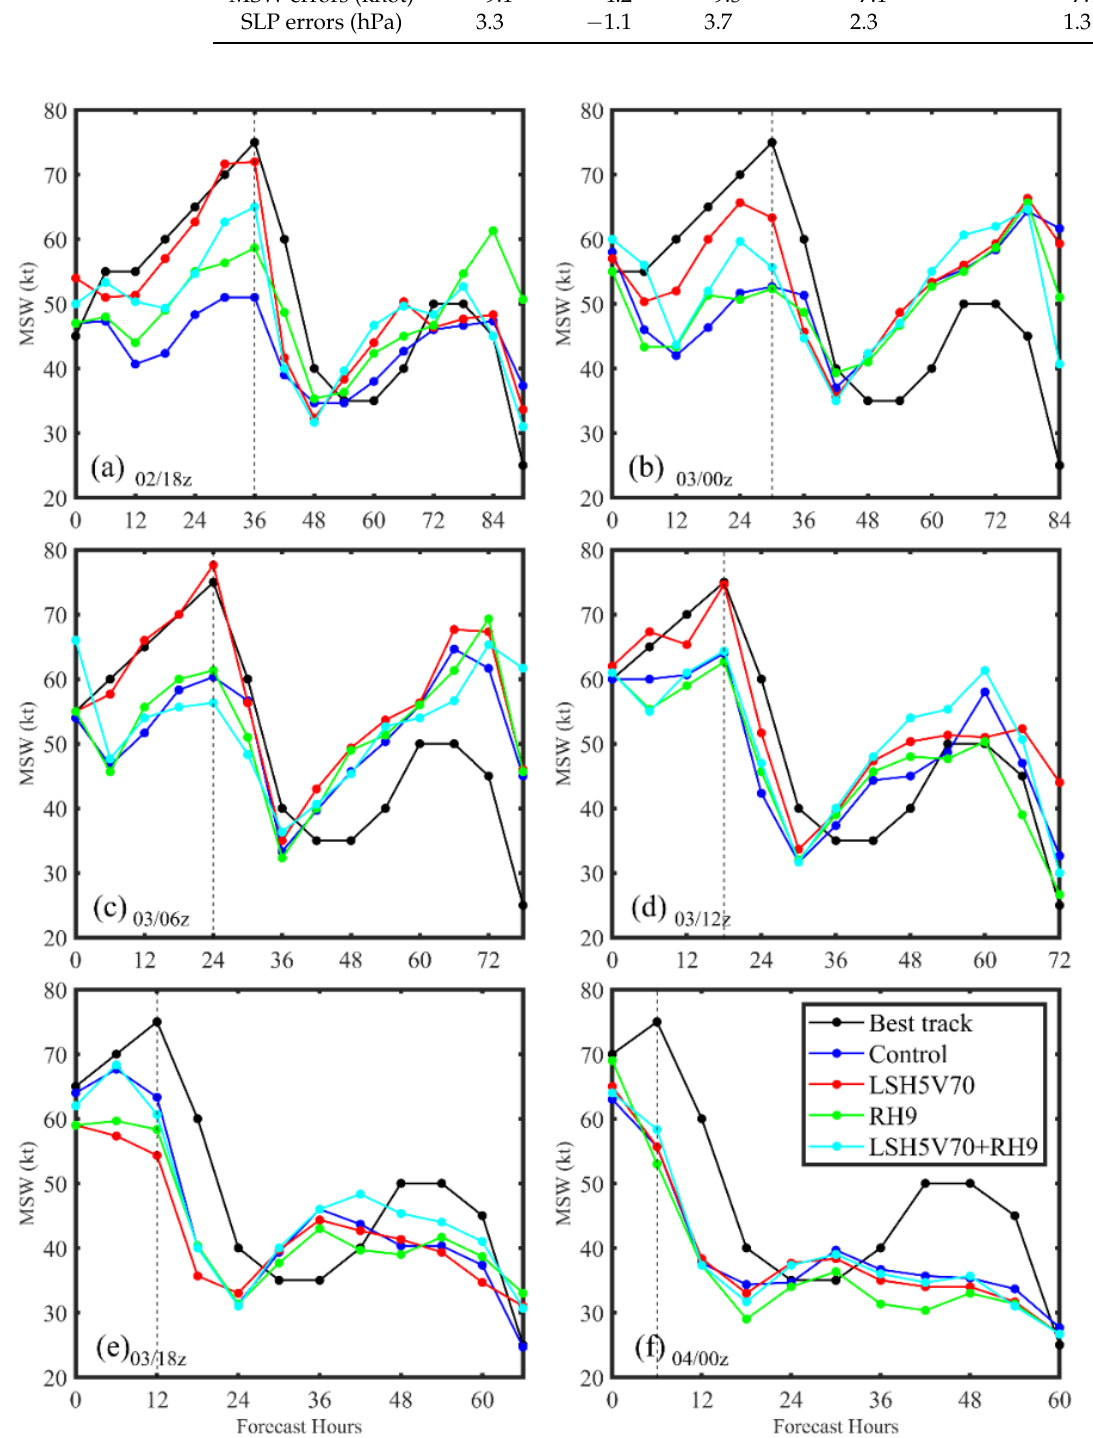
Figure 10. Comparison of the forecast MSW for Hurricane Earl from Control, LSH5V70, RH9, and LSH5V70 + RH9 at ( a ) 18 UTC 2, ( b ) 00 UTC 3, ( c ) 06 UTC 3, ( d ) 12 UTC 3, ( e ) 18 UTC 3, and ( f ) 00 UTC 4 August 2016.